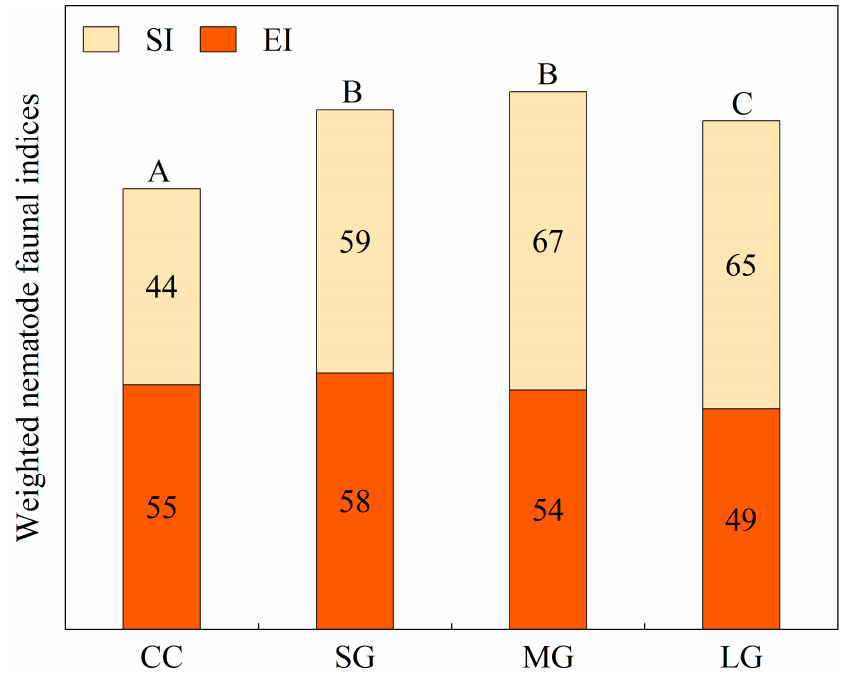
Figure 4. Enrichment index (EI) and structure index (SI) values for the four treatments. CC, closed canopy; SG, small gaps; MG, medium gaps; LG, large gaps. Food web diagnostic quadrants are indicated above each bar, and the means are from Ferris et al. [36].